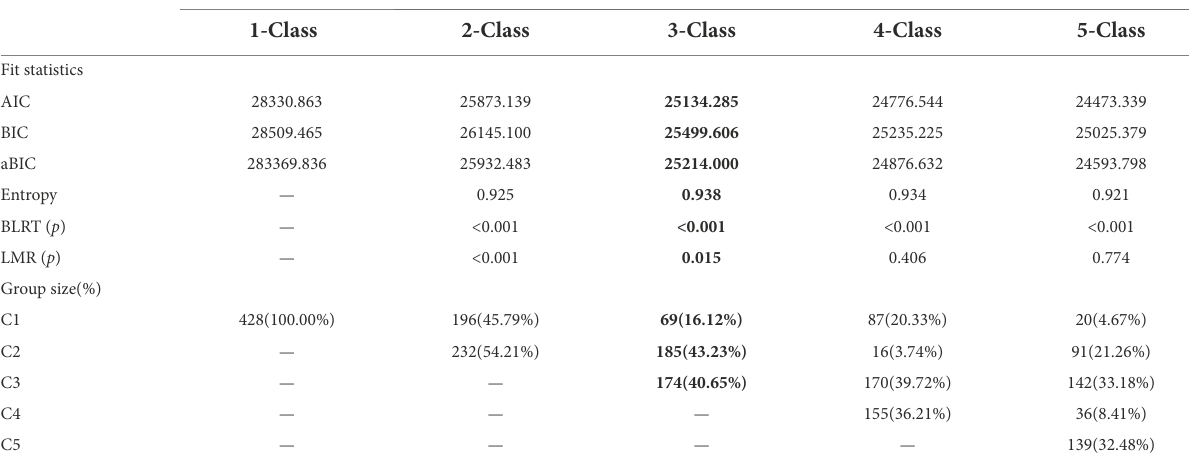
Indices of the best-fitting model are in boldface.